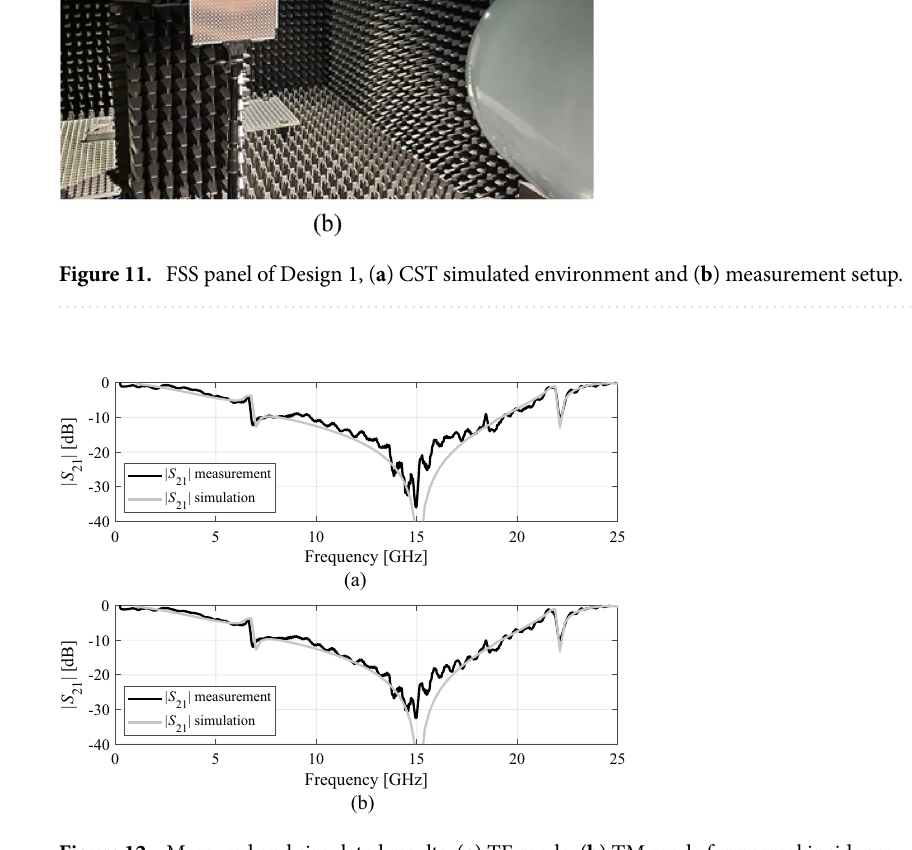
Figure 12. Measured and simulated results, ( a ) TE mode, ( b ) TM mode for normal